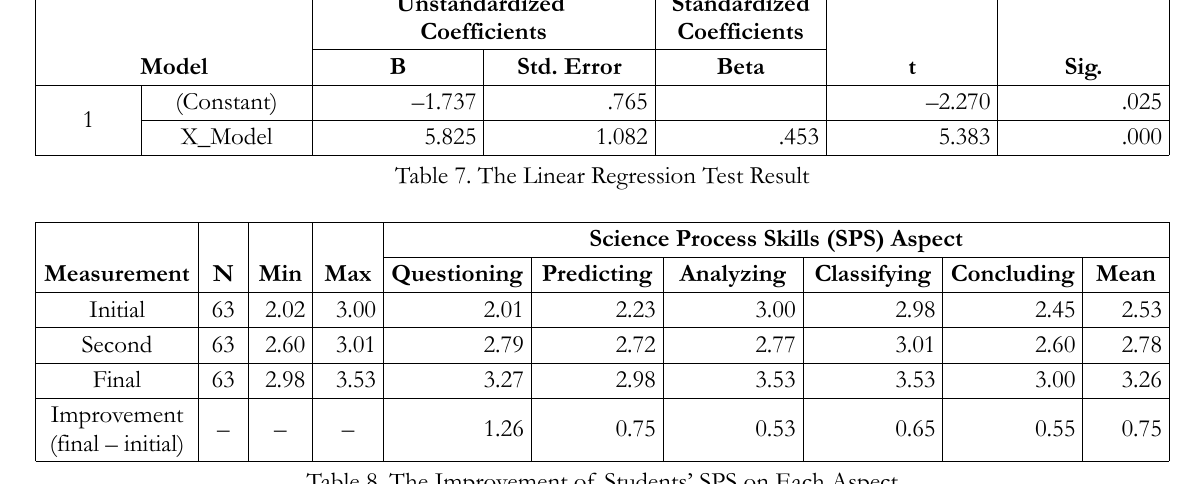
Table 8. The Improvement of Students’ SPS on Each Aspect